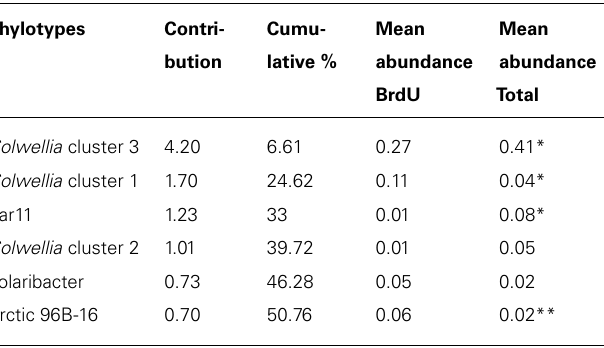
Cumulative % represents the added contributions of individual phylotypes to the differences between groups. * indicates a significant difference between means. ** Significant difference in February